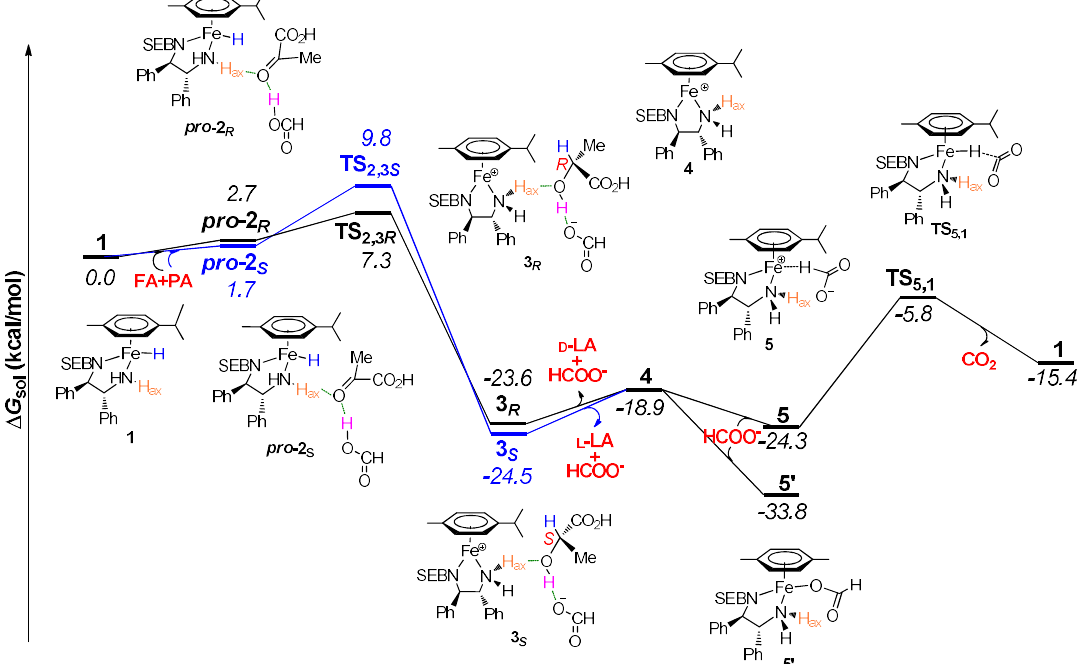
Figure 1. Free energy profile for the ATH of pyruvic acid (PA) catalyzed by 1 with the participation of one formic acid (FA) molecule. The spin-states of all intermediates and transition states are triplet.